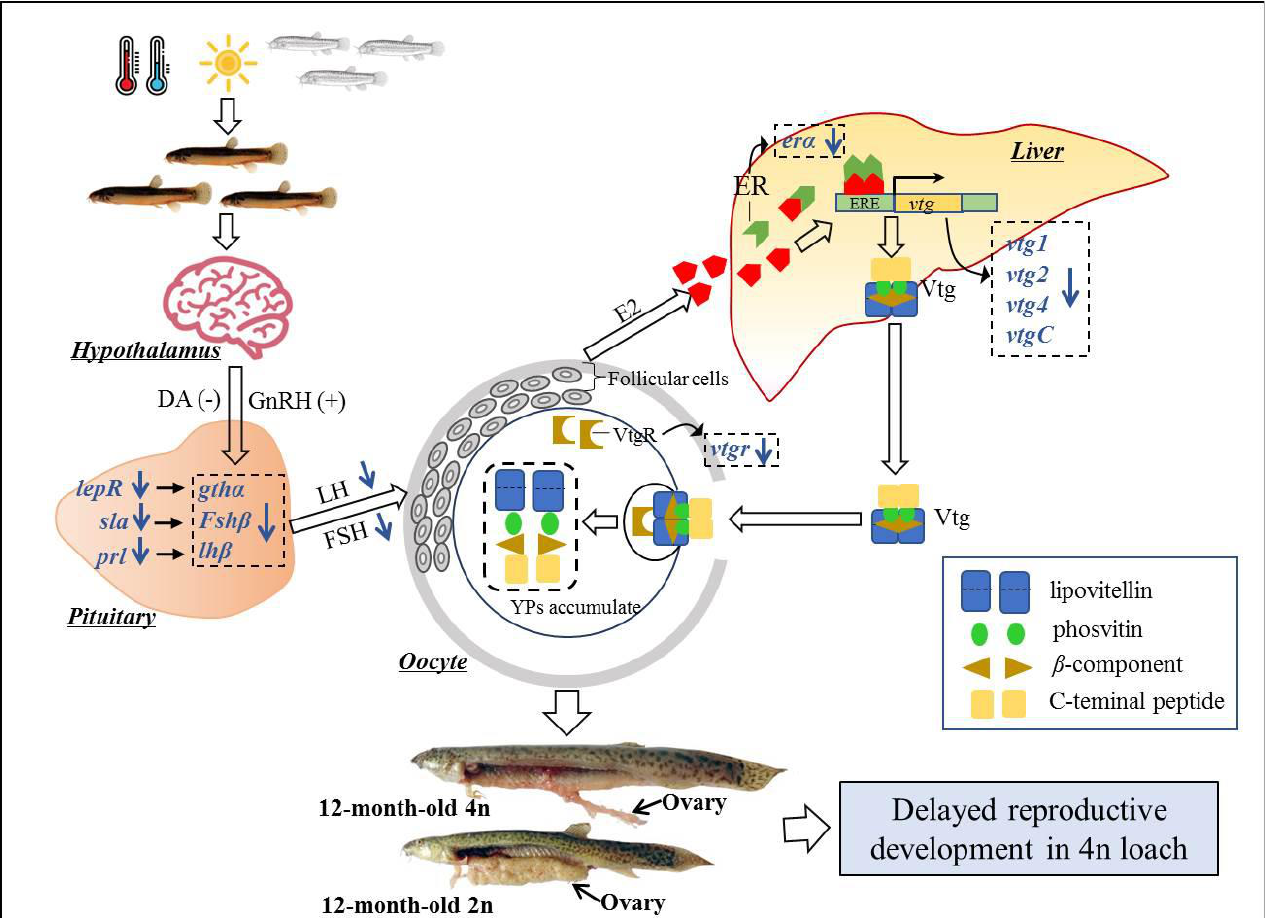
Figure 3. Illustration of the delayed ovarian development in tetraploid M. anguillicaudatus from the vitellogenesis pathway